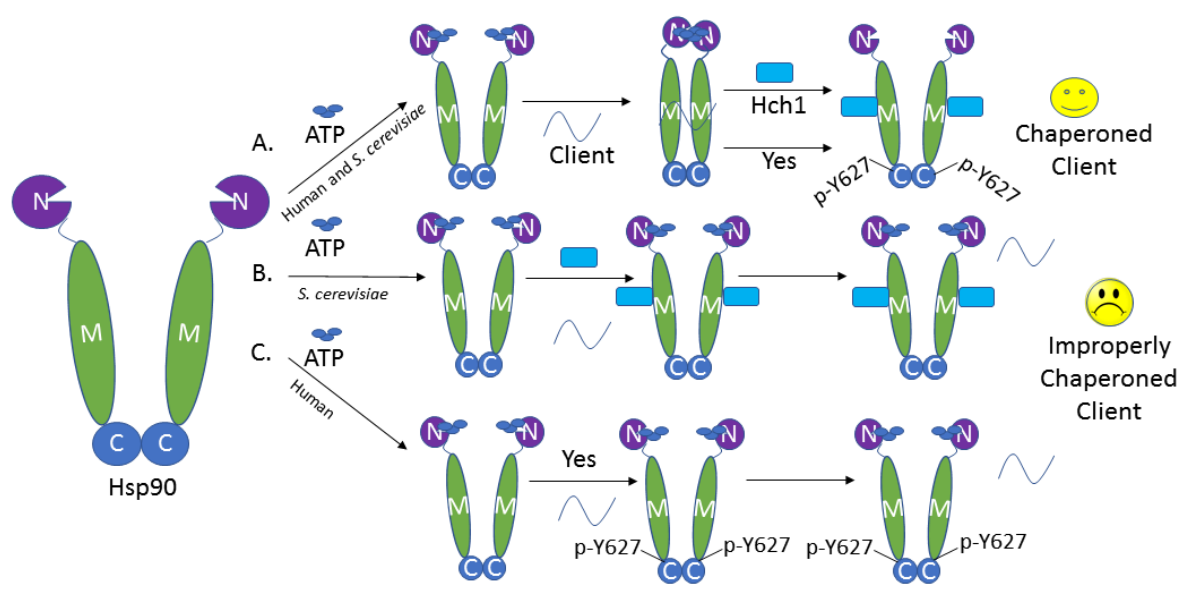
FIGURE 1: Hch1 interaction to yeast Hsp90 and phosphorylation of Y627 in human Hsp90 impact client chaperoning through restricting Hsp90 conformational changes. (A) Normal ATP-driven client chaperoning in both humans and yeast. Appropriate interaction of Hsp90 with Hch1 (yeast) or phosphorylation of Hsp90-Y627 (human) promotes release of chaperoned client. (B) Deregulated Hch1 interaction with yeast Hsp90 restricts its conformational flexibility, resulting in reduced client chaperoning. (C) Deregulated phosphorylation of human Hsp90 at Y627 phenocopies consequences of deregulated Hch1 interaction in